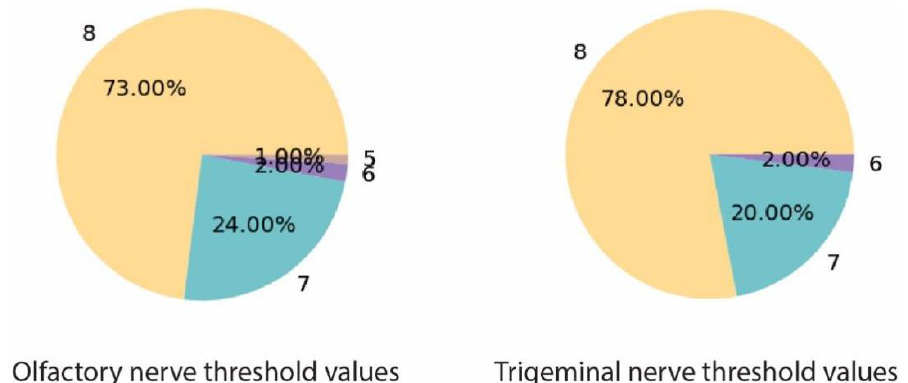
Figure A1. Pretest values of the olfactory and trigeminal nerve sensitivity among the healthy population. Scores and percentages are represented for subjects with marked score ( n = 100).